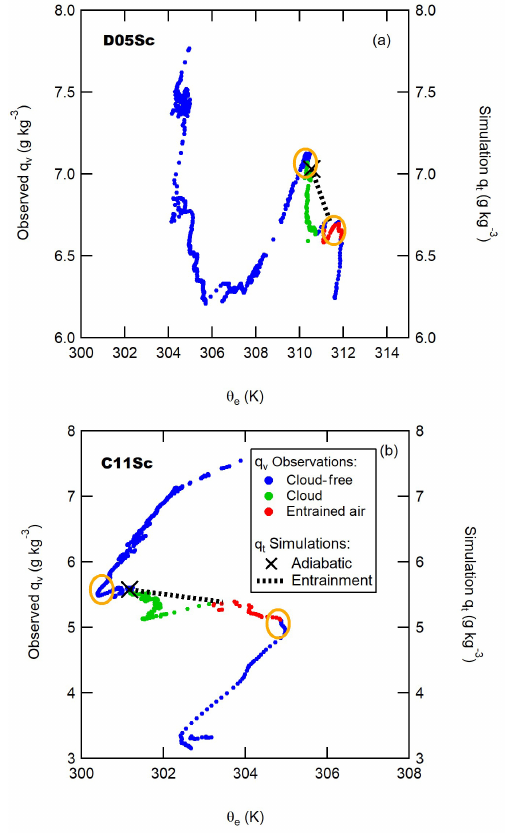
Figure 10. Conservative variables, water vapor content ( q v , con- servative in subsaturated conditions and derived from RH mea- surements) and equivalent potential temperature ( θ e ) identify mix- ing between cloud air and entrained air for flights D06Sc (a) and C11Sc (b) . Measurements are defined as cloud-free (blue), in-cloud (green) or entrained-air properties used in simulations (red). The or- ange circles highlight what is suggested to be the non-mixed sources of air.